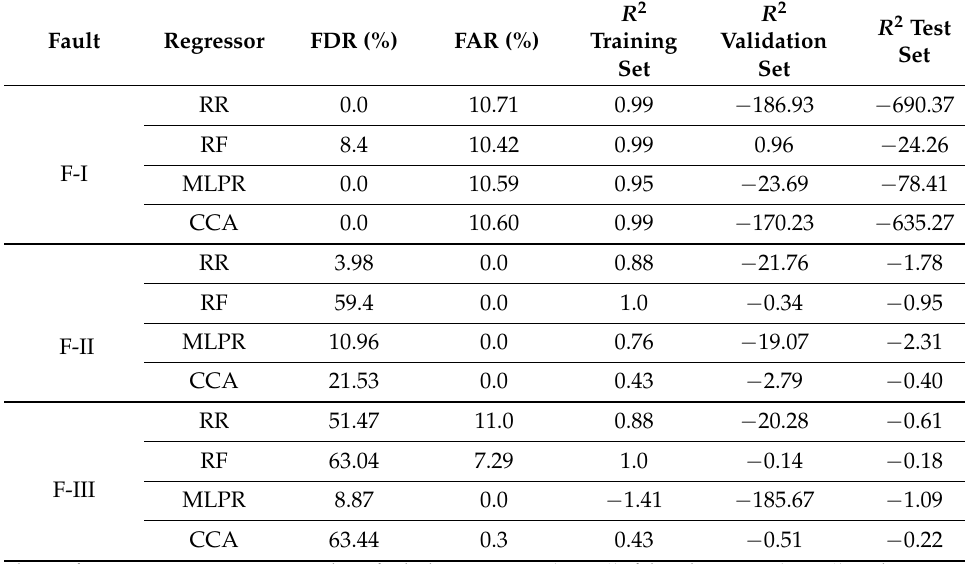
Table 6. Reference performance when variable selection procedures were not used to analyze the industrial